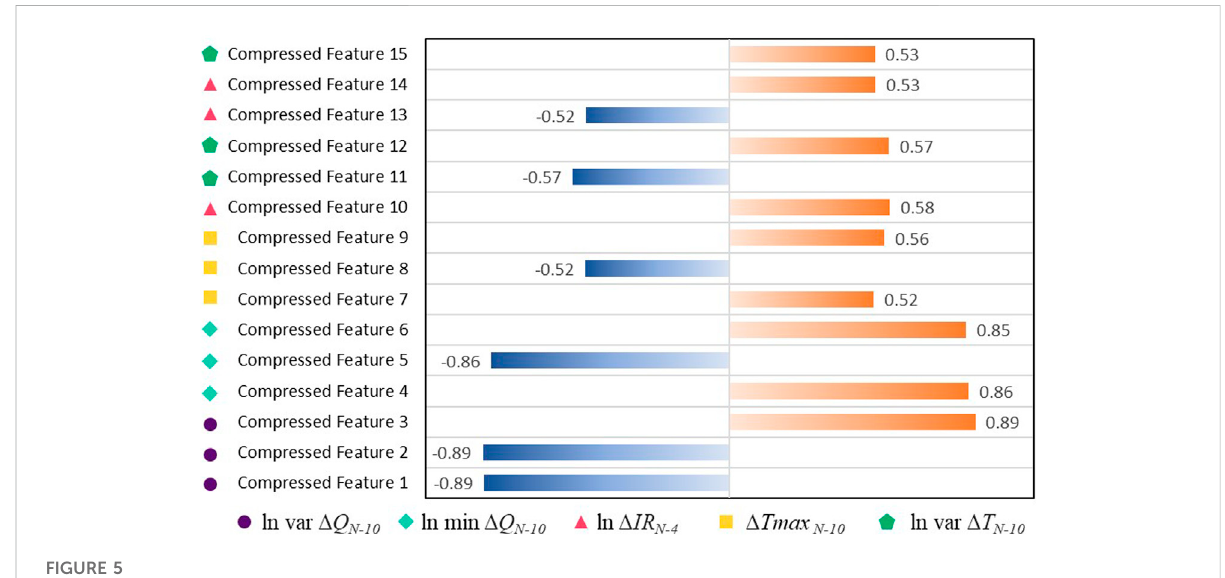
FIGURE 5 The Pearson correlation coef fi cient of the compressed